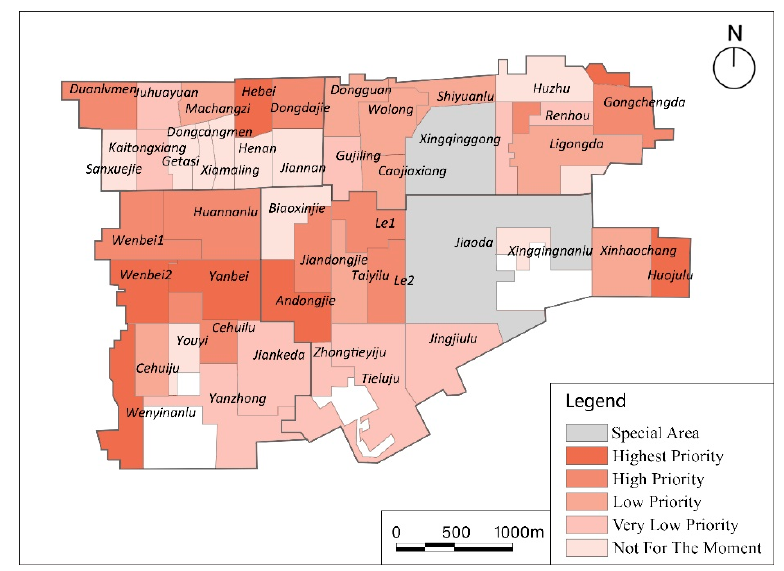
Figure 7. Suggestions of priority areas to increase the number of community care facilities or beds.